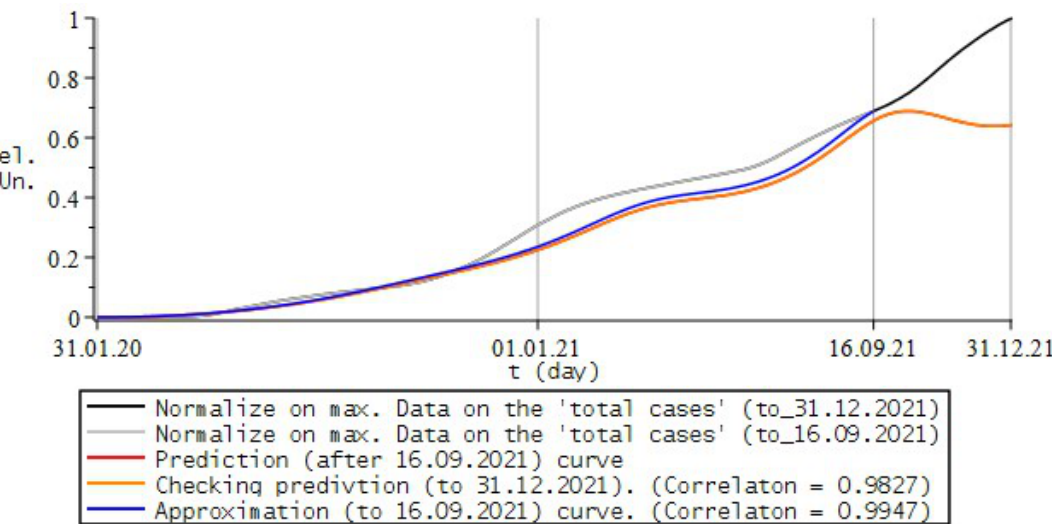
Figure 17. Russian Federation. Model curve: (blue)—approximation, with a correlation coefficient: 99.4%; (red)—forecast, through 31 December 2021; (orange)—verification of the forecast with the correlation coefficient: 98.2%. The red curve and the orange curve are obviously the same.